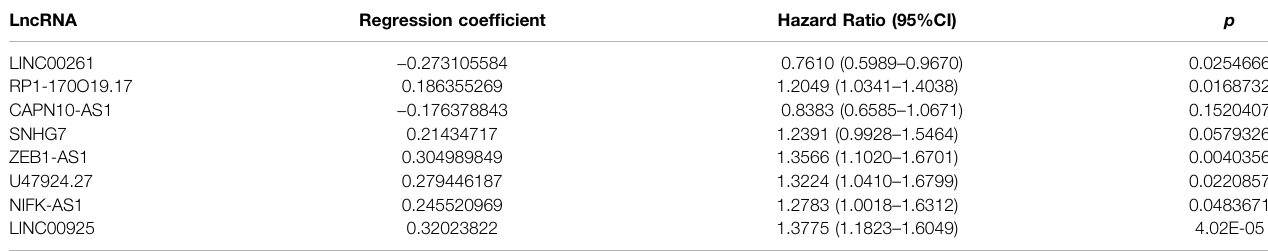
TABLE 2 | Eight prognostic risk signatures closely related to metastasis. LncRNA Regression coef fi cient Hazard Ratio (95%CI)